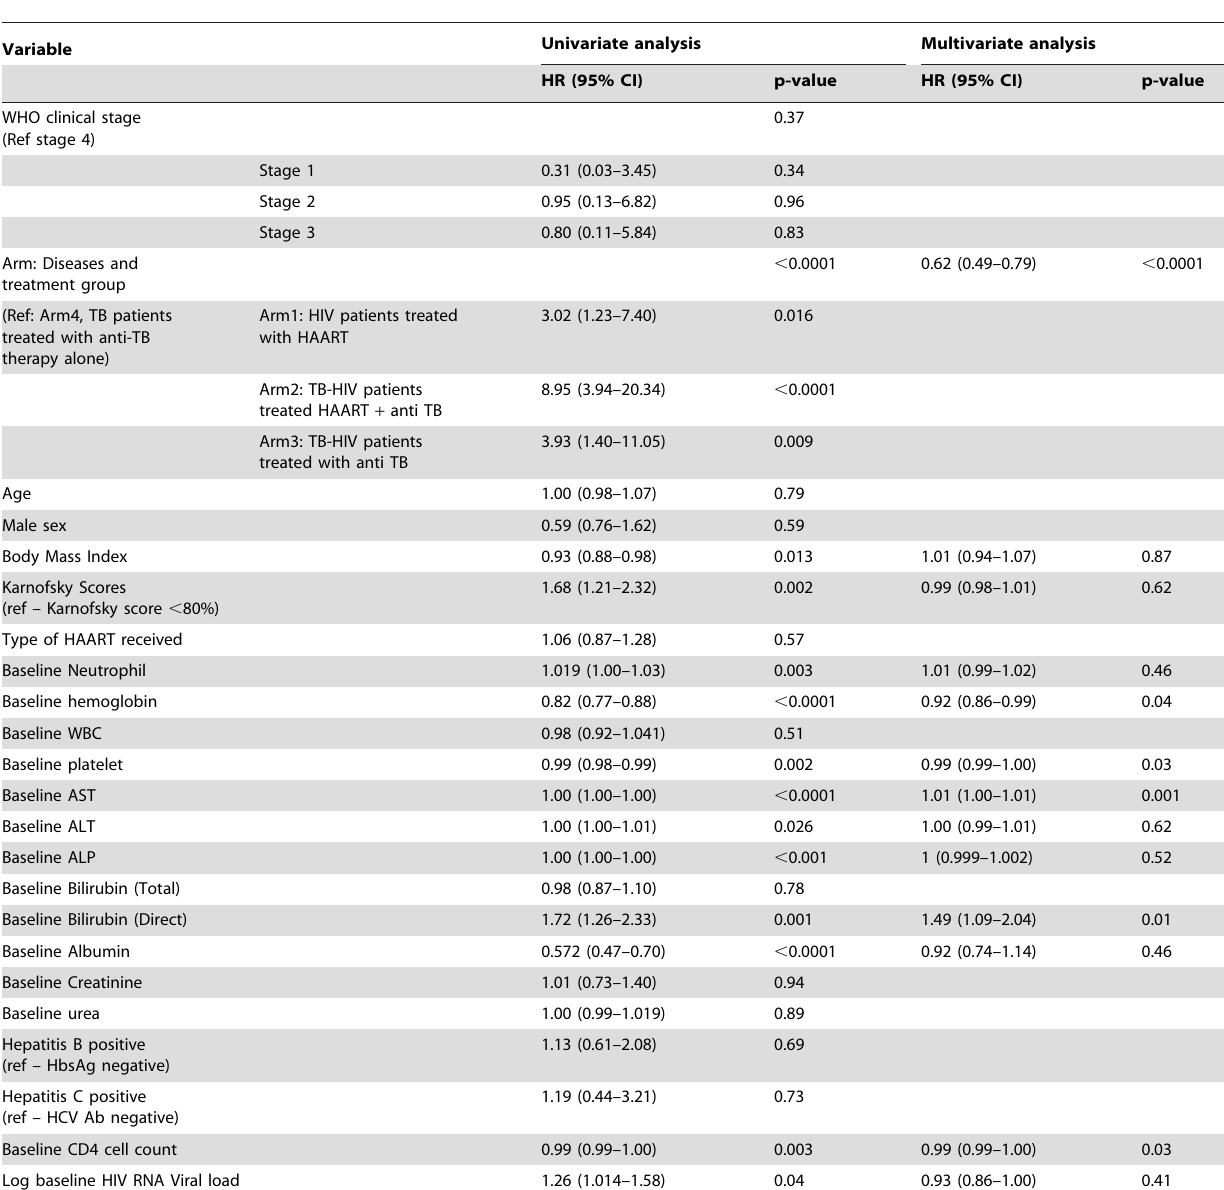
Table 3. Univariate and Multivariate Cox proportional regression analysis to show the risk factors for developing DILI. HR = hazard